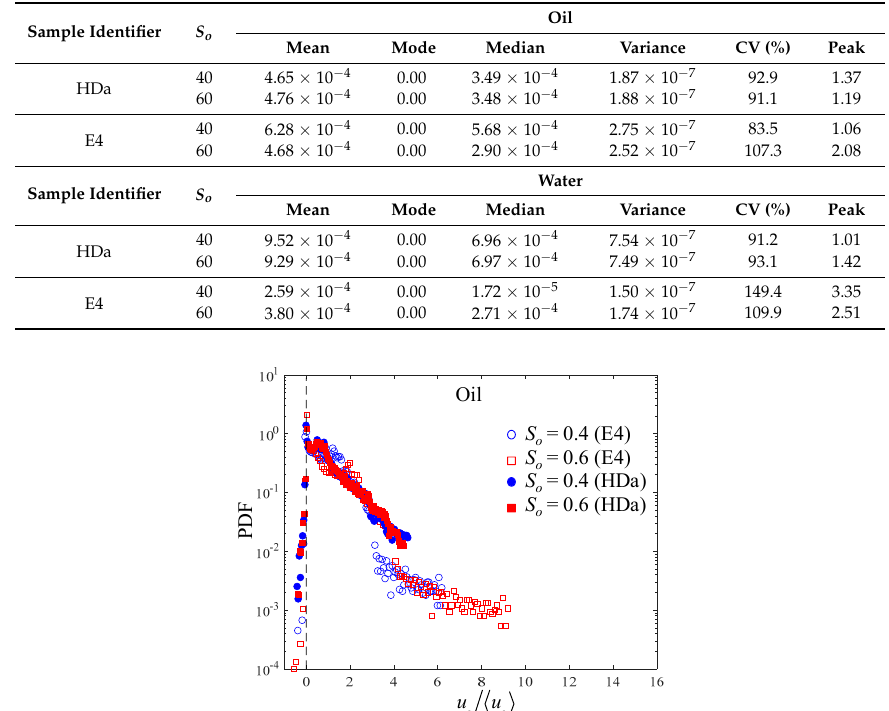
Figure A1. Sample PDFs of u o / (cid:104) u o (cid:105) , u o and (cid:104) u o (cid:105) , respectively being the horizontal component of the velocity vector of oil phase and its mean. Full and empty symbols respectively are associated with sample HDa and E4. Blue circles and red squares respectively correspond to S o = 0.4, 0.6. The dashed line identifies the peak value of the sample PDFs. Water 2017 , 9 , 252